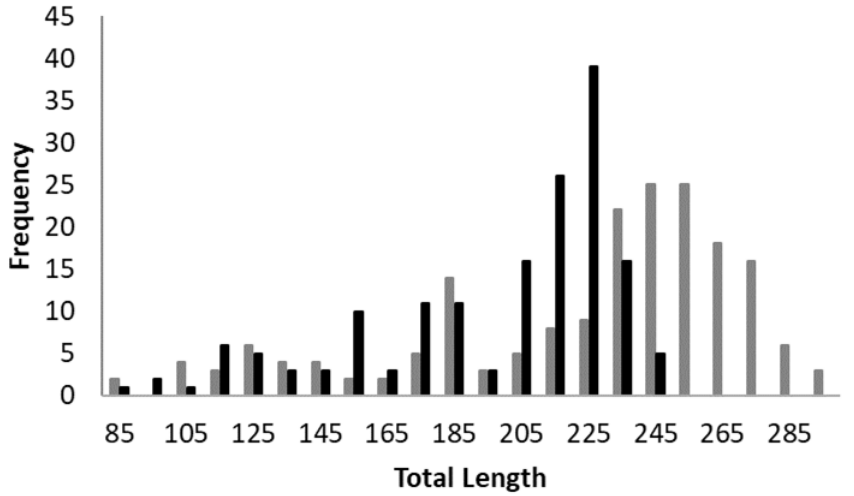
Figure 1. Frequency distribution of total length of Urotrygon microphthalmum captured in northeastern Brazil. Black bars, males; gray bars, females. Vertebral radius ( VR ) varied between 0.34 to 1.7 mm for females, with 1 to 9 pairs of bands counted. For males, the VR ranged from 0.38 to 1.14 mm and 1 to 6 pairs of bands were counted.